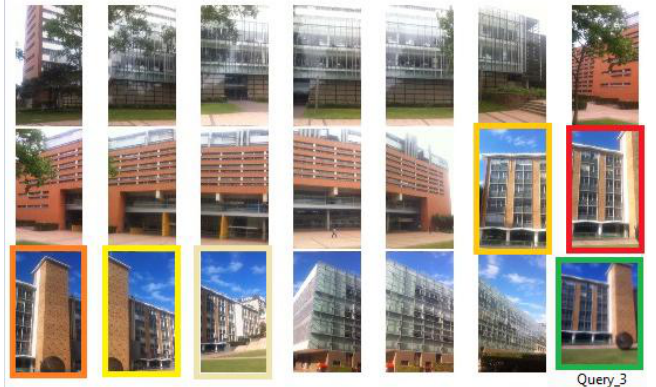
Figure 10. Image retrieval: 5 top ranked images have been identified from the image space with 20 reference images. Query image has a green border when the five top voted reference images have borders from dark red to light yellow, the darker the colour the higher rank it has (which indicates greater relevance). All top voted reference images indicates the same target building, BD No.